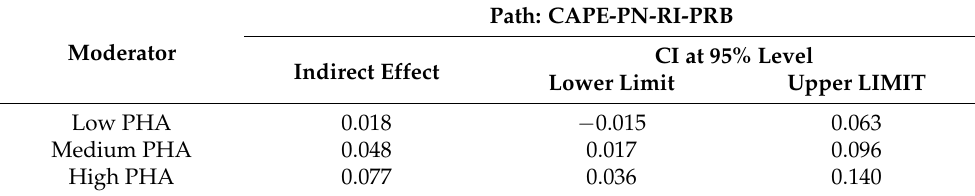
Table 4. The analysis of moderated chain mediation effect.